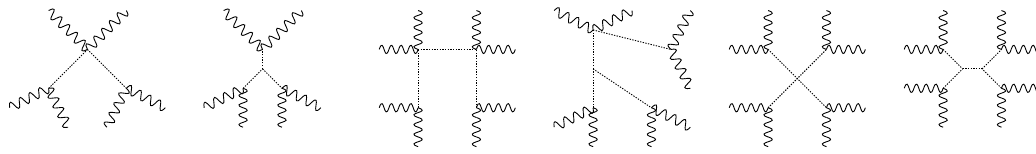
and Z 8 processes in unitary gauge, L L